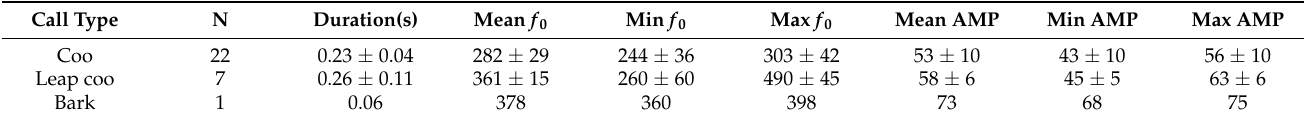
Figure 1. Representative spectrogram vocalizations. ( a ) Coo ; ( b ) leap coo ; ( c ) bark. Table 4. Acoustic parameter summaries for each call type.